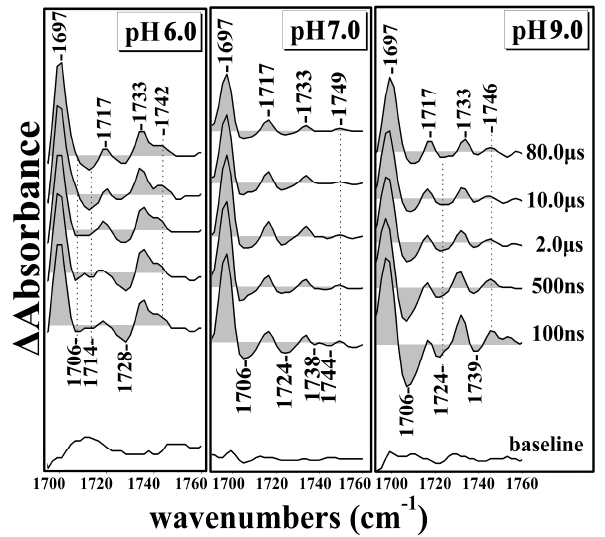
Figure 5. Time Resolved Step-Scan Fourier Transform Infrared (TRS 2 -FTIR) difference spectra of 1690–1760 cm − 1 region ( t d = 100–80,000 ns, 4 cm − 1 spectral resolution) of fully-reduced ba 3 -CO subsequent to CO photolysis by a 7 ns 532 nm laser pulse at pH 6.0, 7.0, and 9.0.